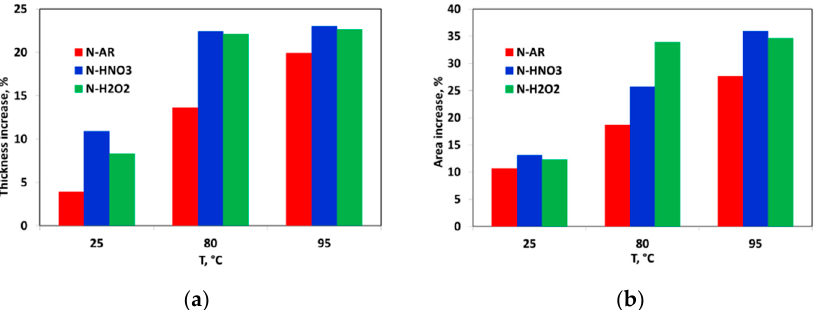
Figure 4. ( a ) Percentage variation of thickness; ( b ) Percentage variation of area from dry to wet state for N-AR (red bar), N-HNO3 (blue bar) and N-H2O2 (green bar) as a function of temperature.